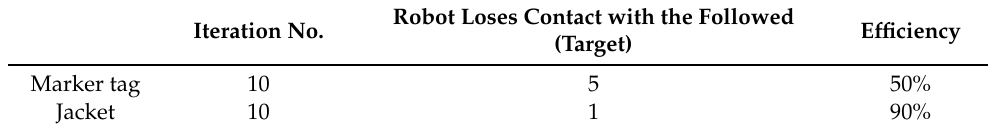
Table 5. Tabular representation of results. Robot Loses Contact with the Followed Iteration No. Efficiency (Target) Marker tag